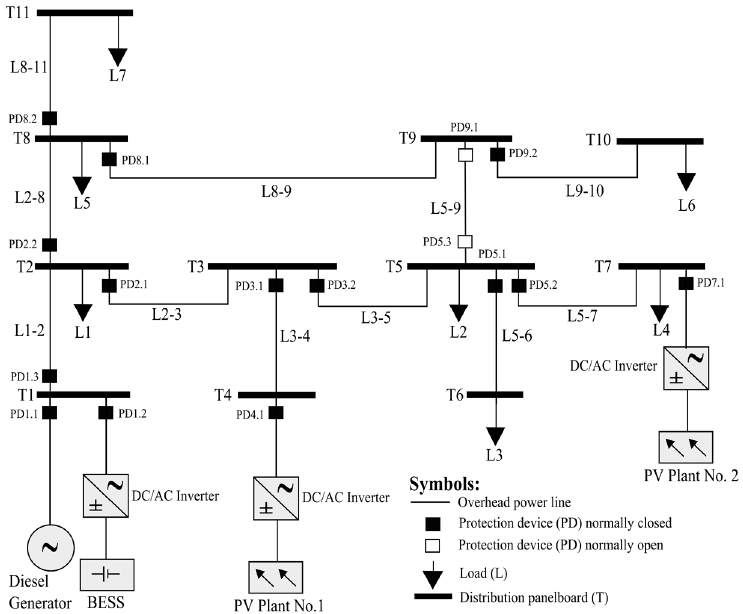
Figure 4. Single line diagram of the ESUSCON microgrid. Table 2. Distributed generation units’ ratings of the microgrid.